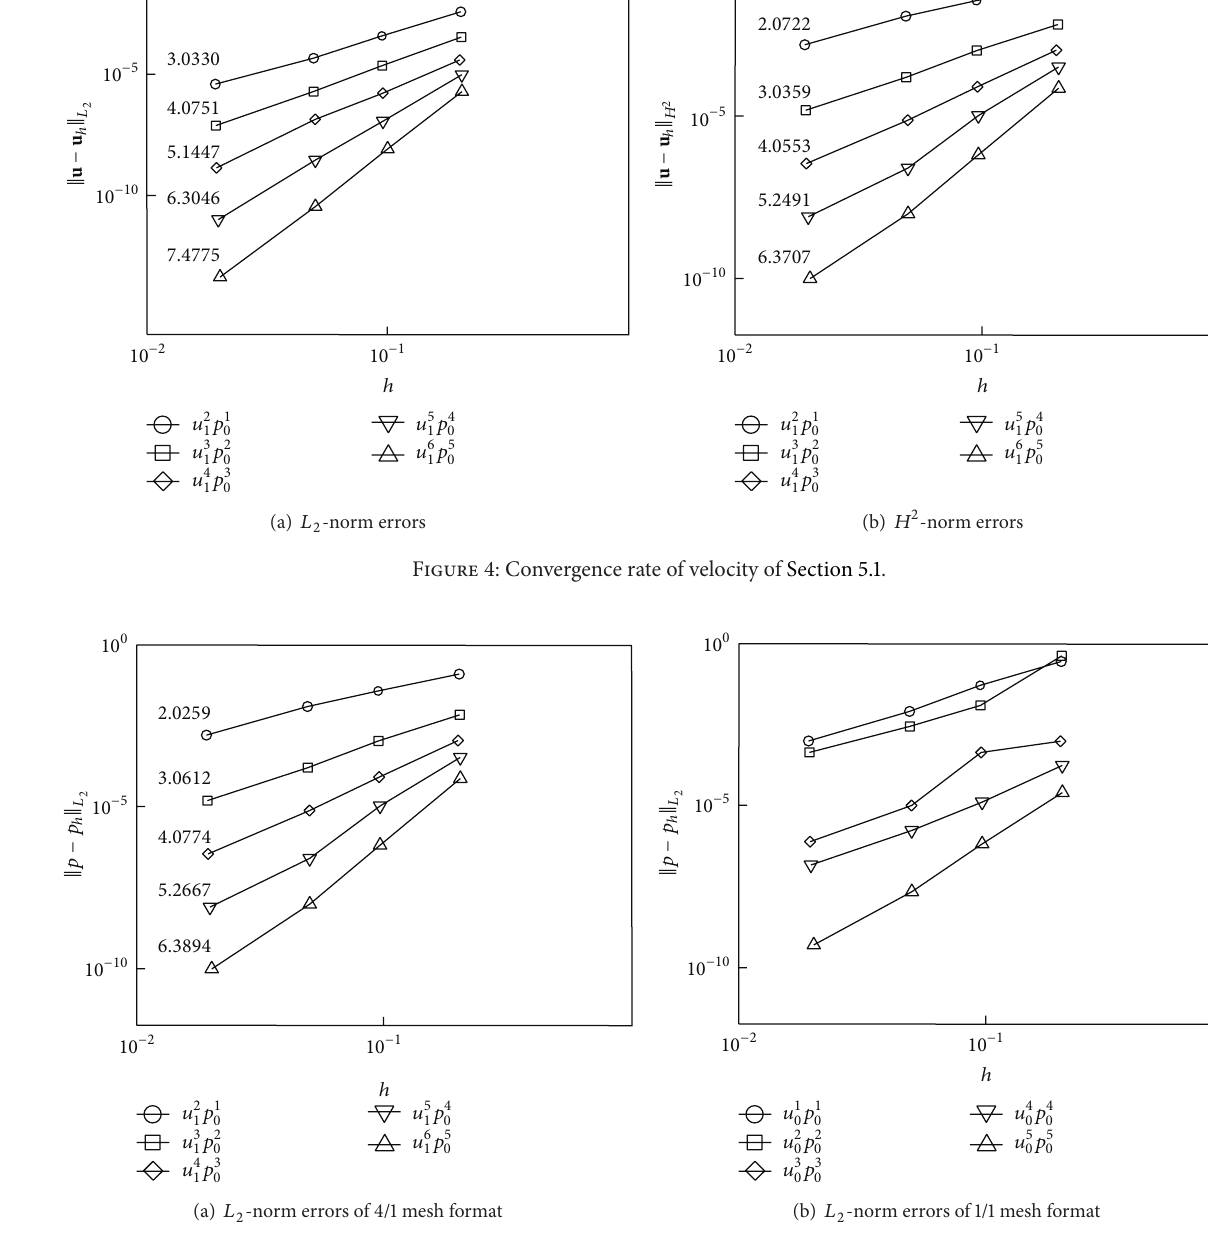
Figure 5: Convergence rate of pressure of Section